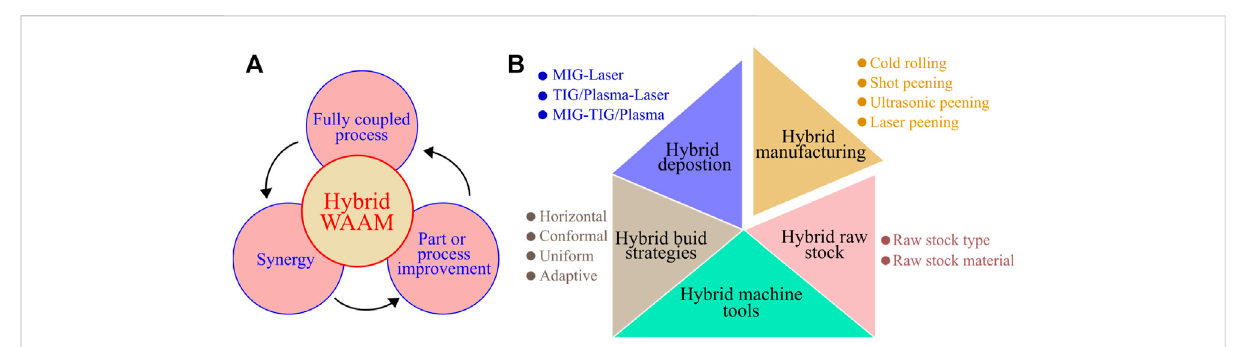
FIGURE 4 (A) Features and (B) levels of